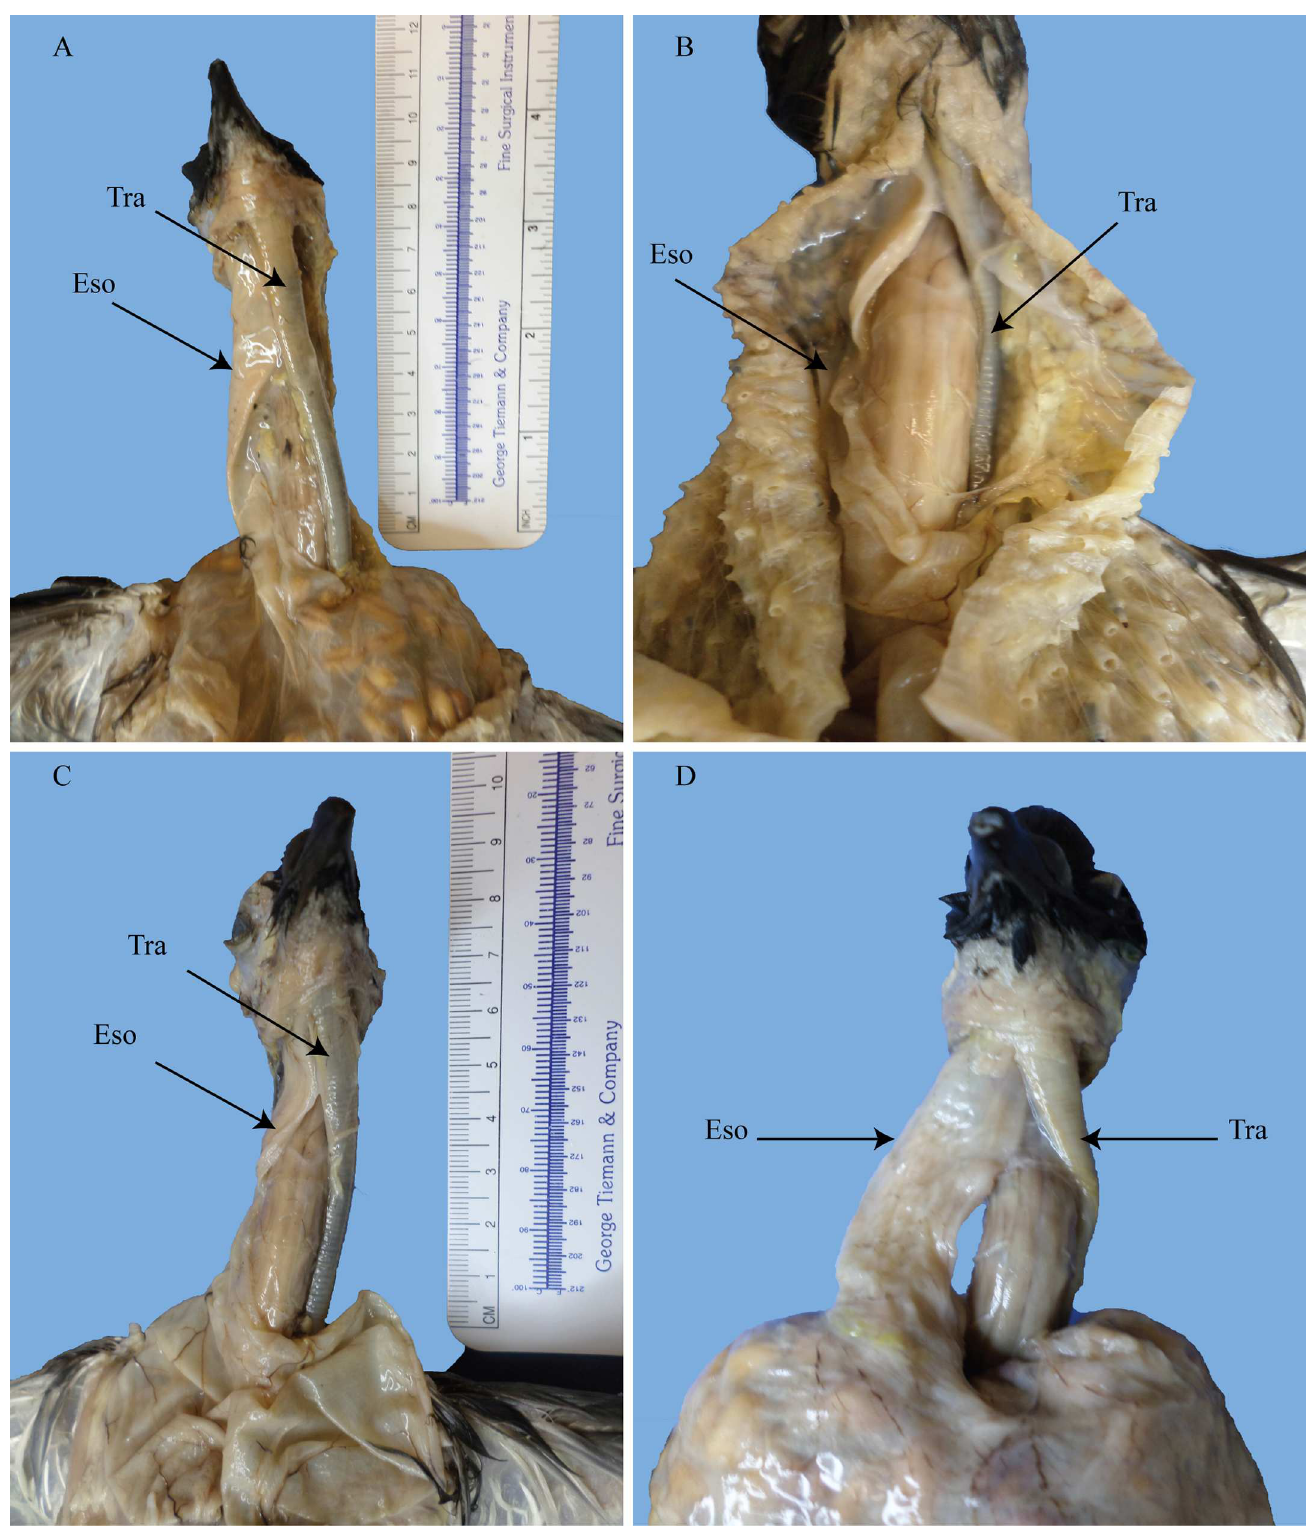
Fig 5. Pigeonsshowingindividualvariationof the degreeand immediacy of displacement. A and C show a more gradual displacementof the trachea while B and D show a more immediatedisplacement of the trachea.D also shows a stronglydorsolateral placement of the trachea having been pushed dorsallydue to a filled crop. Tra = trachea;Eso = esophagus.